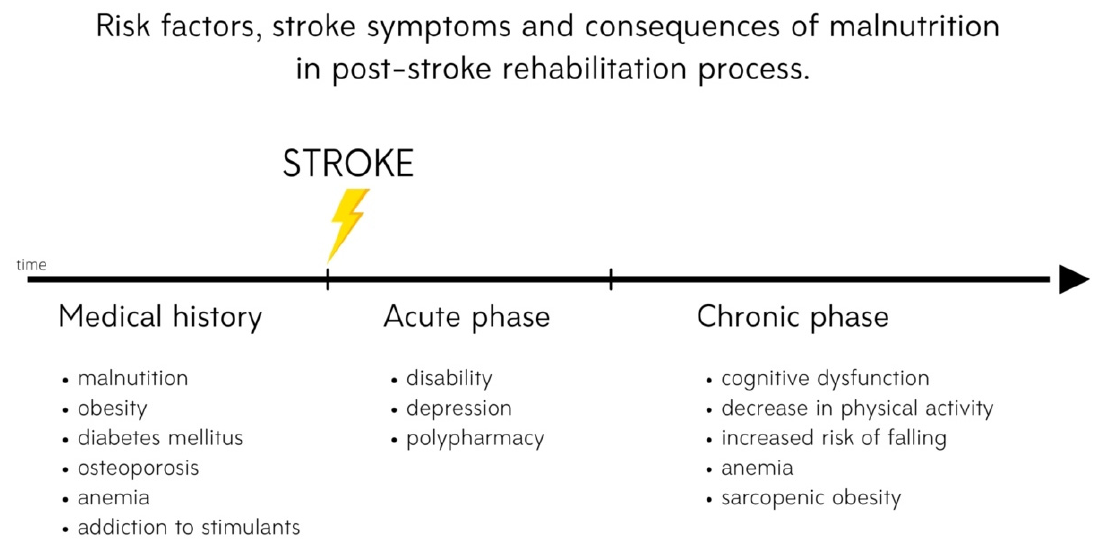
Figure 1. Risk factors, stroke symptoms and consequences of malnutrition in the post-stroke rehabilitation process.